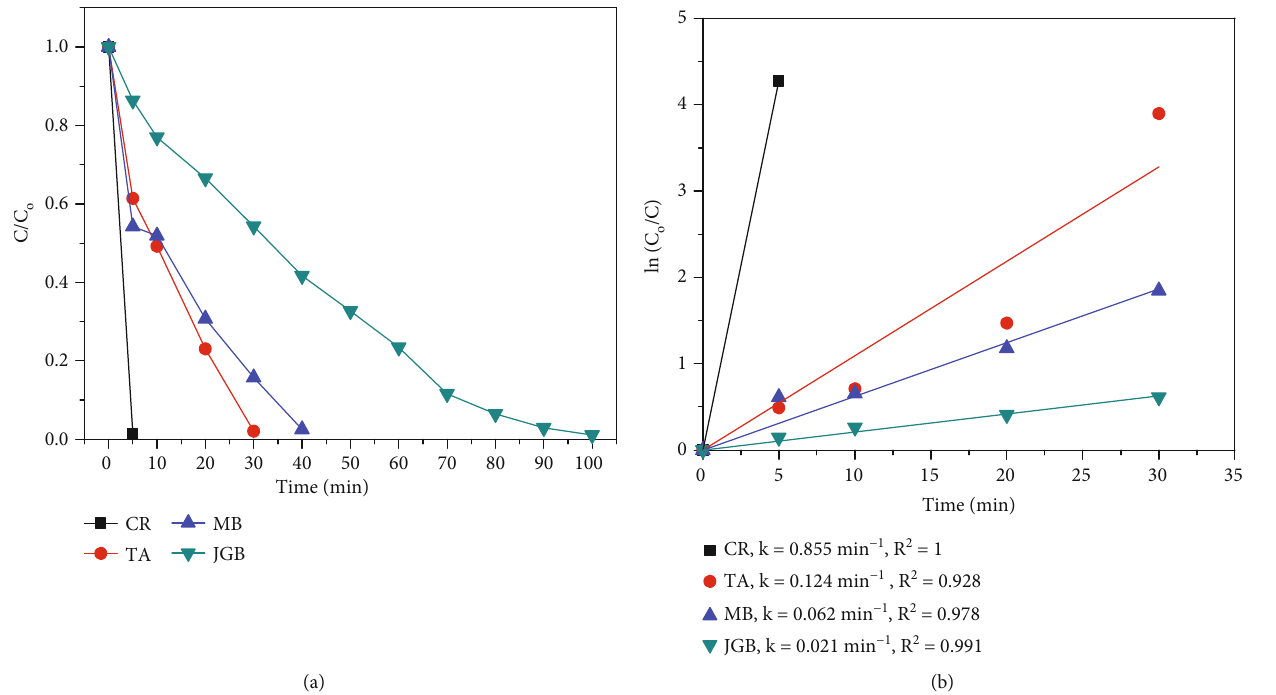
Figure 15: (a) Degradation of the di ff erent organic dyes on Au/ZnO-5 composite; (b) the kinetic curves. The reaction conditions: catalyst dosage of 0.5g/L, dyes concentration of 10mg/L, solution pH of 6.0, and Hg lamp of 250